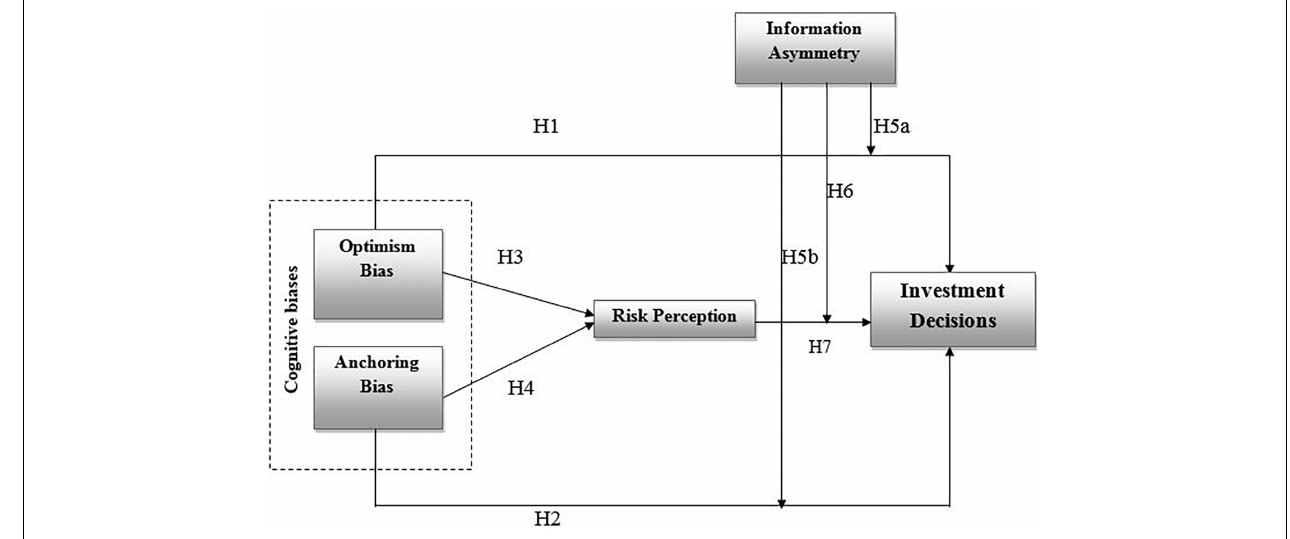
FIGURE 1 | Conceptual framework.